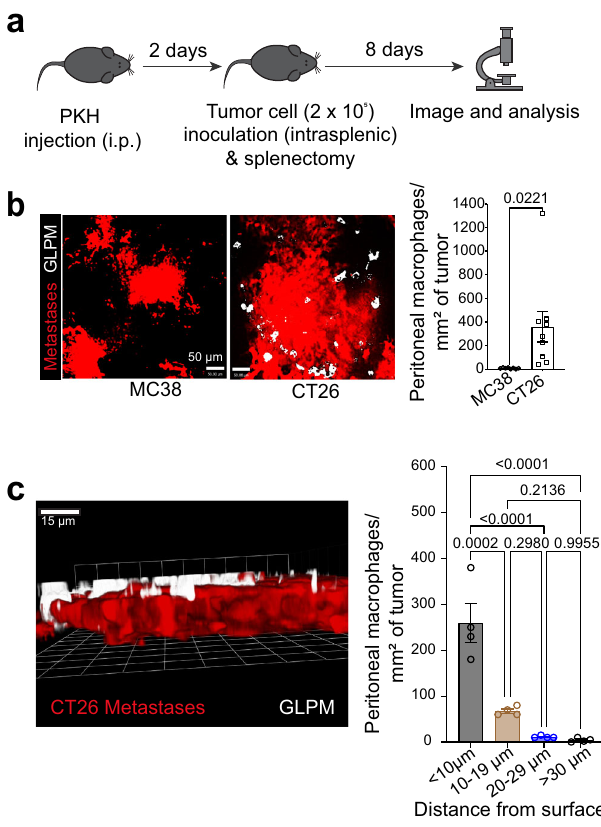
Fig. 1 | CT26 liver metastases recruit Gata6 + large peritoneal macrophages (GLPMs). a PKH dye injection and cancer metastasis model. b Representative confocalimages(left;scalebar=50 μ m)oflocalizationandquanti fi cation(right)of PKH + GLPMs (White) in MC38 (Red) and CT26 (Red) liver metastases ( n =8 for MC38, n =9 for CT26; from three independent experiments), P values were calcu- latedusingtwo-tailedunpaired t test P =0.0221. c Representative3Dimagingofthe distribution of GLPMs (white) and CT26 cancer metastasis (red; left) and quanti fi - cation of GLPM penetration into metastasis (right) ( n =4; from one experiment), P values were calculated using ordinary one-way ANOVA with Tukey ’ s multiple comparisonstest, P =0.0002<10 µ mvs10 – 19 µ m, P <0.0001<10 µ mvs20 – 29 µ m, P <0.0001<10 µ m vs >30 µ m, P =0.2980 10 – 19 µ m vs 20 – 29 µ m, P =0.2136 10 – 10 µ m vs 30 µ m, P =0.9955 20 – 29 µ m vs >30 µ m. All graphs are presented as mean±SEM. Source data are provided with this